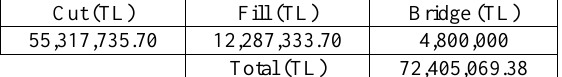
Table 10. Approximate total cost of constructing an alternative